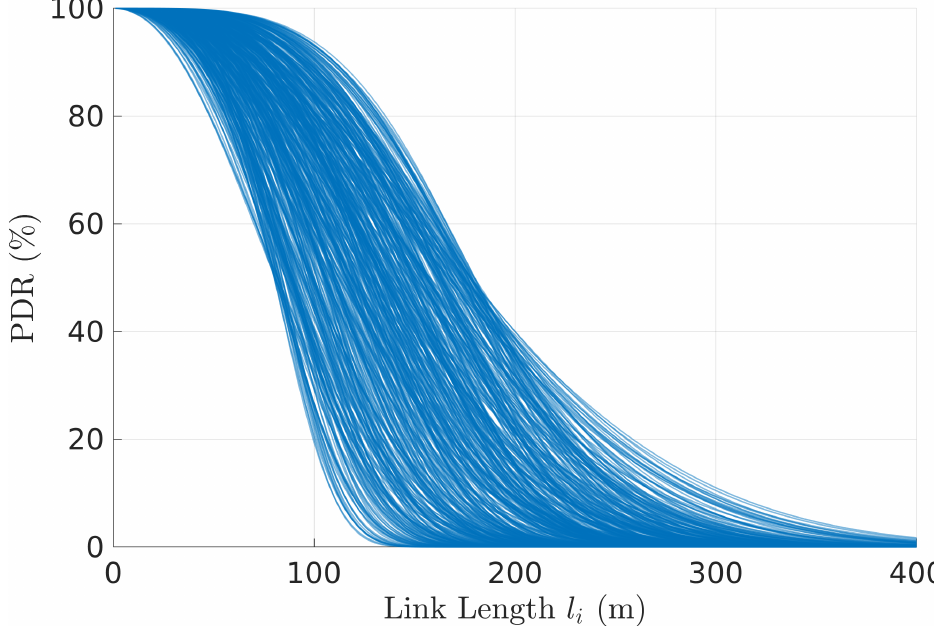
Figure 11. Pool of link PDR models ( R , α ) used for the general performance characterization ( R ∈ [ 80,180 ] and α ∈ [ 2.1,4.2 ] ).